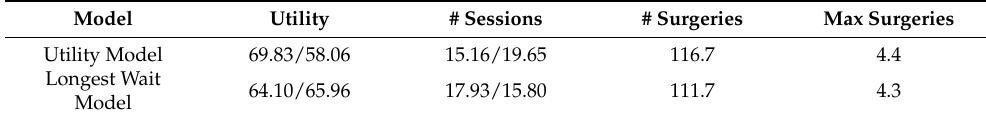
Table 6. Comparative